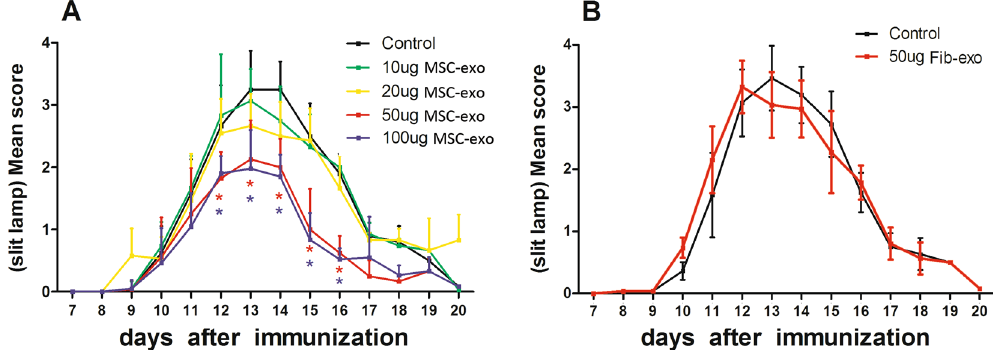
Figure 2. Periocular injection of MSC-Exo ameliorated uveitis in rats. ( A ) Both eyes of the immunized rats were injected periocularly with different doses of MSC-Exo (10, 20, 50, and 100 μ g) or with an equal volume of PBS (control) on a daily basis for 7 consecutive days starting from the 9 th day post immunization. B: 50 μ g FIB- exo or an equal volume of PBS was administrated in the same way as above. Asterisks indicate the significant differences between control (black curve) and exosomes treated (blue curve), Values are expressed as the mean ± SD of six rats (12 eyes) per group. * P < 0.05.